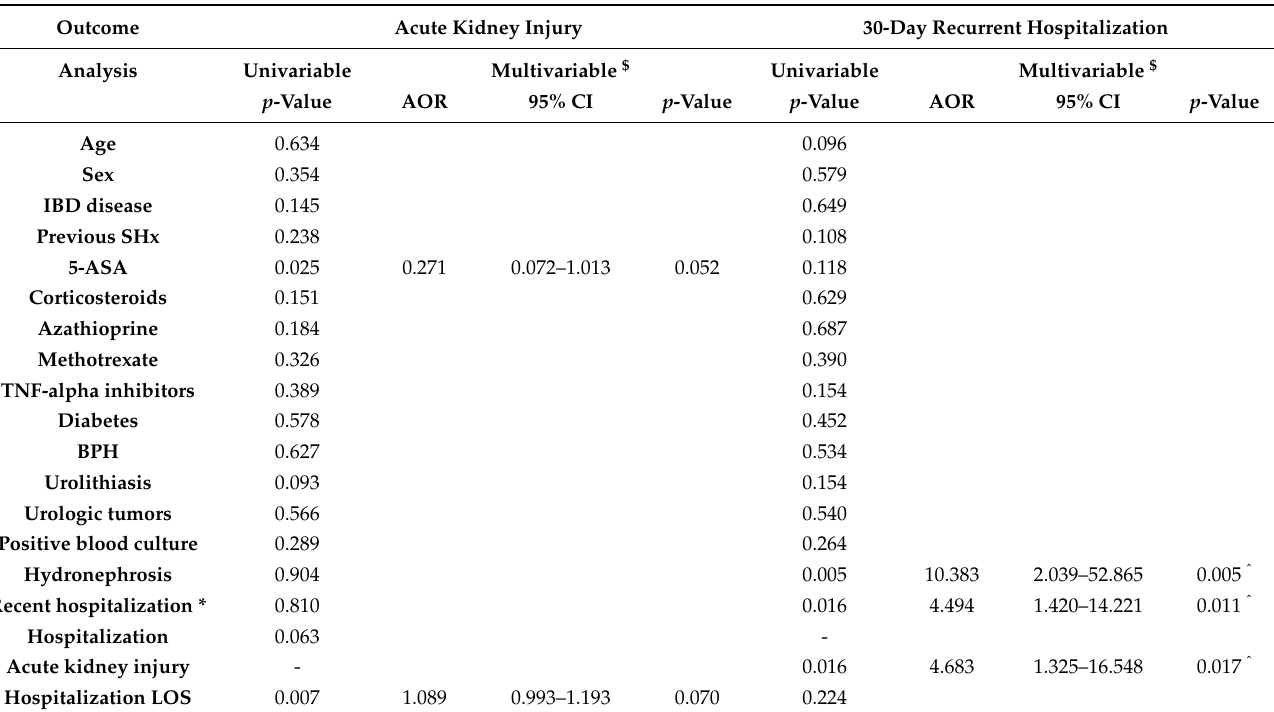
Table 5. Univariable and multivariable analyses: odds ratio and adjusted odds ratio for acute kidney injury and 30-day recurrent hospitalization among IBD patients treated for urinary tract